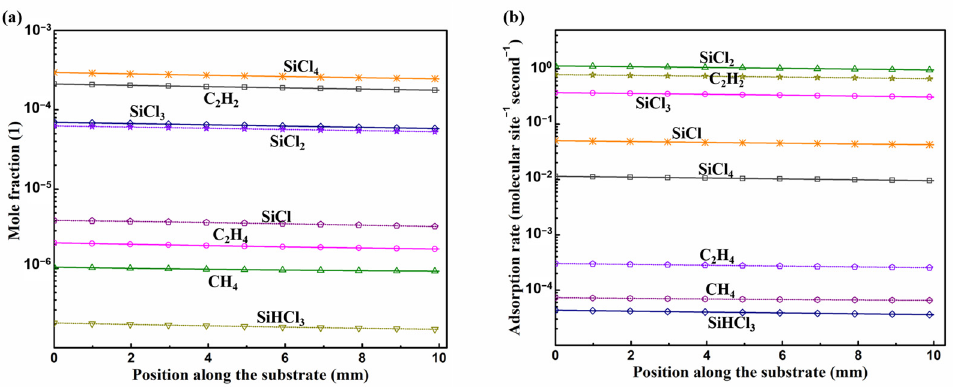
Figure 5. ( a ) Mole fraction and ( b ) adsorption rate of Si/C contained intermediate species on the substrate surface.